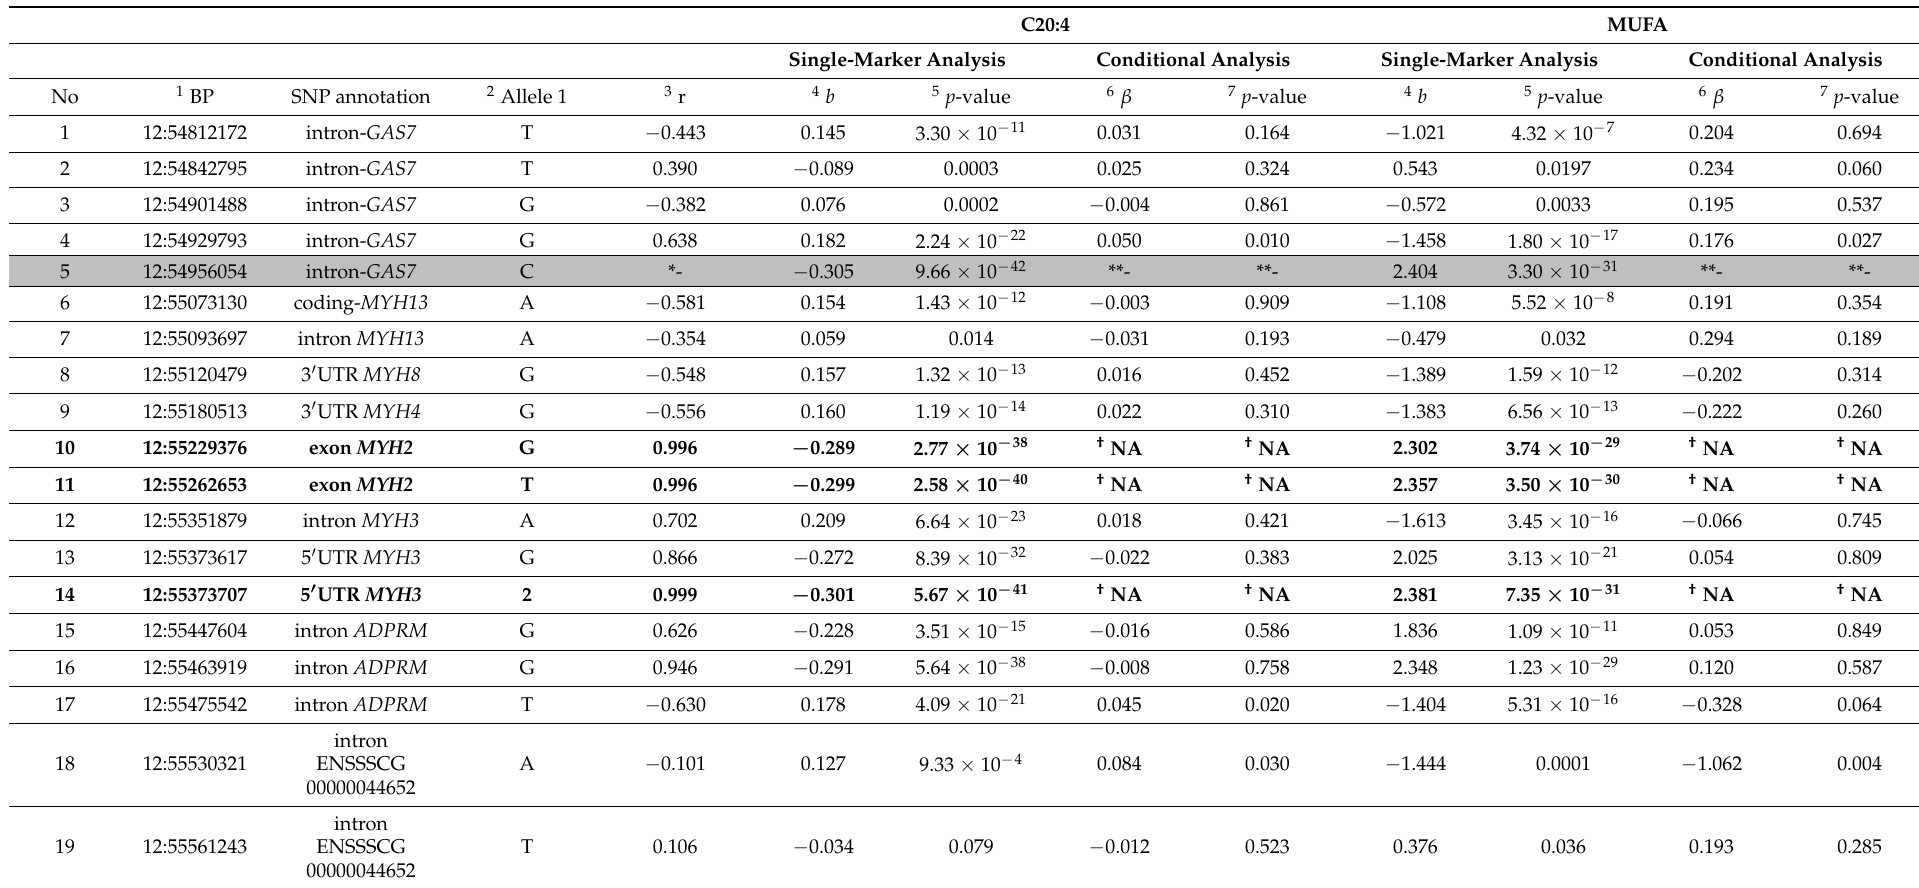
Table 4. Results of conditional association analyses for C20:4 and MUFAs using SNP markers in the 749.1 kb critical region in SSC12. C20:4